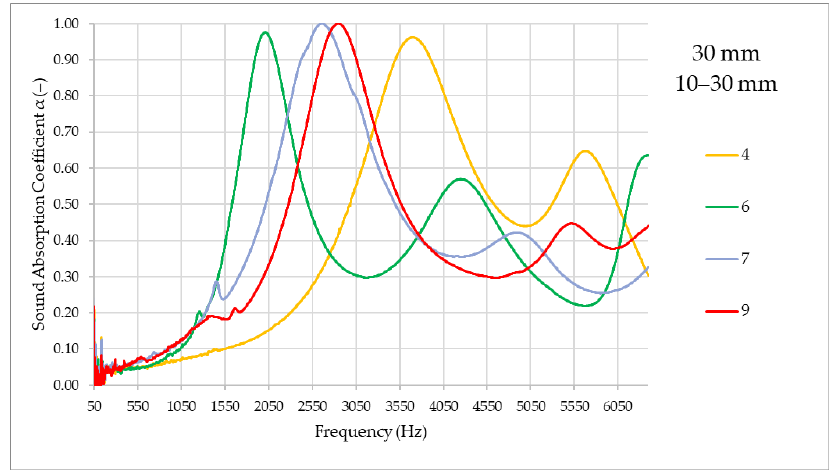
Figure 3. Sound absorption coefficient as a function of frequency of tested specimens of bark panels 1, 2, 5 and 8 with a thickness of 30 mm and a particle size of 4 to 11 mm.